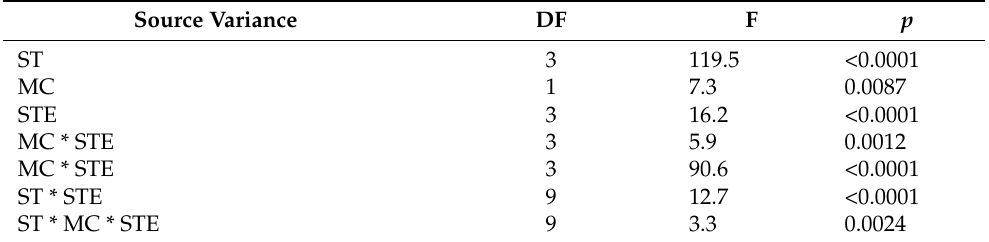
Table 2. Analysis of variance (ANOVA) of the effect of storage time (0, 1, 2, 3 years), moisture content (7, 13%), and temperature of storage (3, − 3, − 10, − 20 ◦ C) on seedling emergence Fagus sylvatica L. seeds. ST, storage time; STE, storage temperature; MC, moisture content.